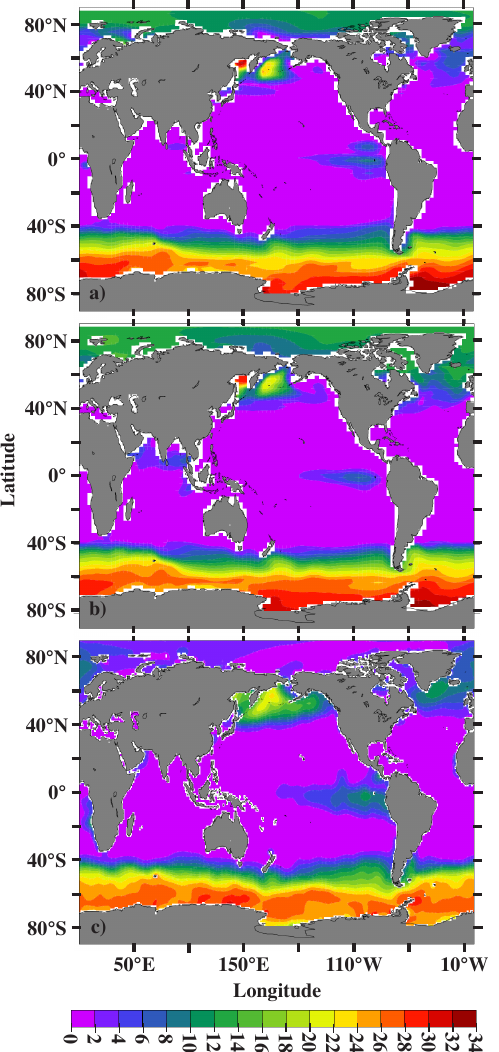
Fig. 9. Annual surface (upper 50m) nitrate concentrations simu- lated with the new (a) and old (b) models and from the WOA09 database (c) .